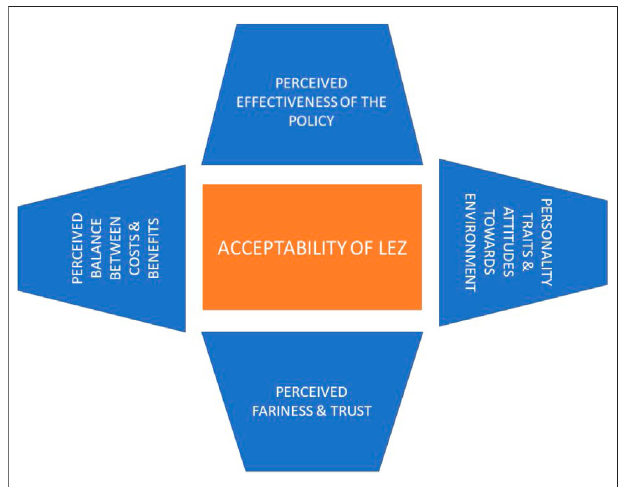
FIGURE 1 | Framework of factors affecting the acceptability of